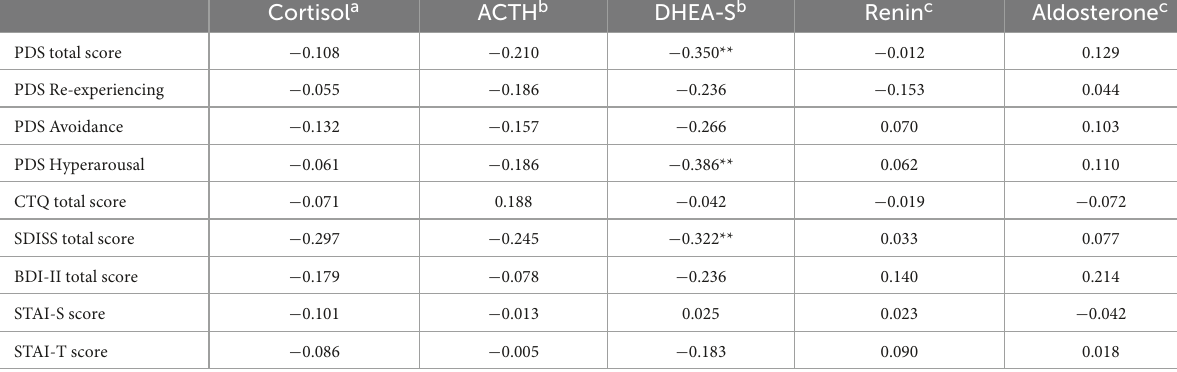
TABLE 3 Correlations of psychological characteristics with HPA axis and RAA system hormones in PTSD